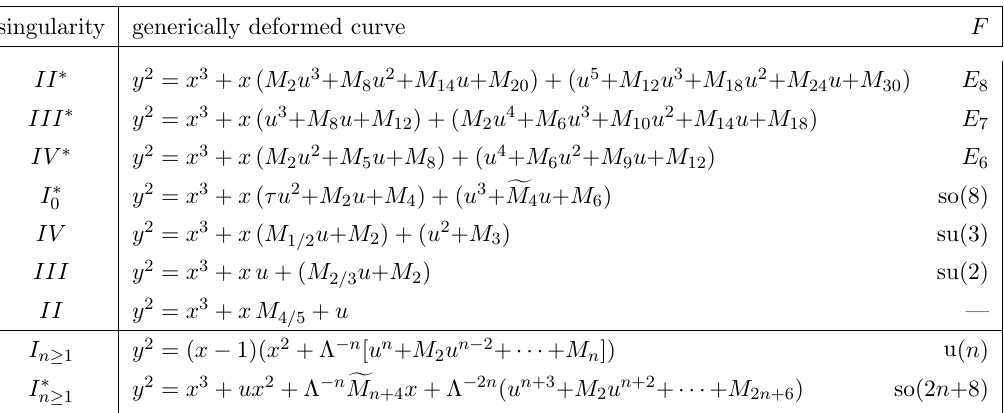
Table 3 . Maximal deformations of the Kodaira singularities along with the associated (cid:13)avor algebra. The subscript on the deformation parameters, M d , is their mass scaling